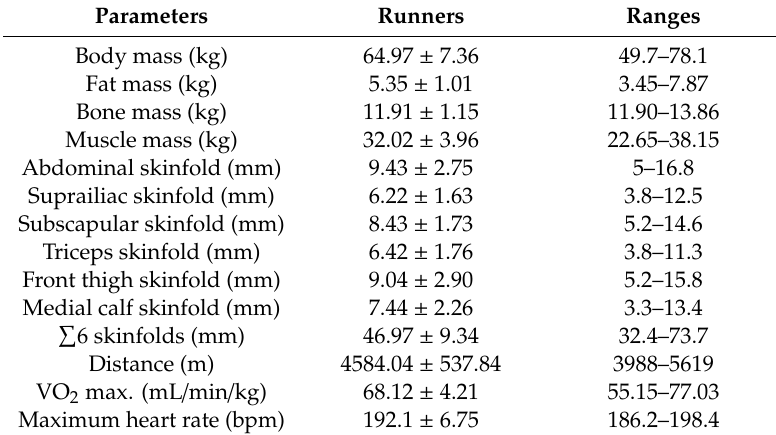
Table 1. Anthropometric, body composition and performance values in the